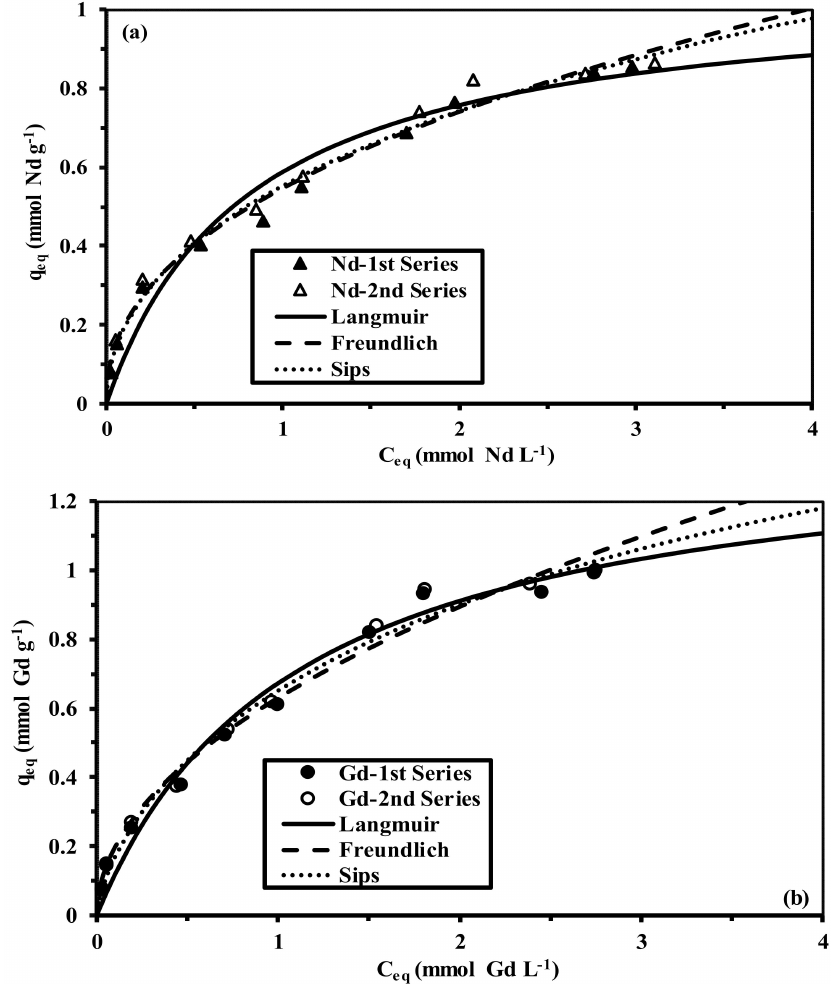
Figure 8. Nd(III)( a ) and Gd(III)( b ) sorption isotherms using mesoporous composite functionalized sorbent—modeling with the pseudo-first-order rate equation (C 0 : 0.62–3.54 mmol metal L − 1 ; pH 0 : 5; pH eq : 4.69–4.48 for Nd(III) and 4.61–4.7 for Gd(III); SD: 0.5 g L − 1 ; agitation speed: 170 rpm; T: 22